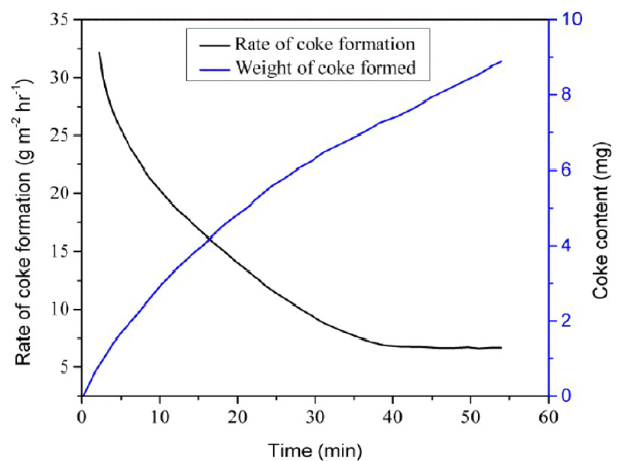
Figure 11. Rate of coke formation and weight content over steel cylinder during thermal cracking of ethane between 750 and 850 °C. Mahamulkar et al. [81].